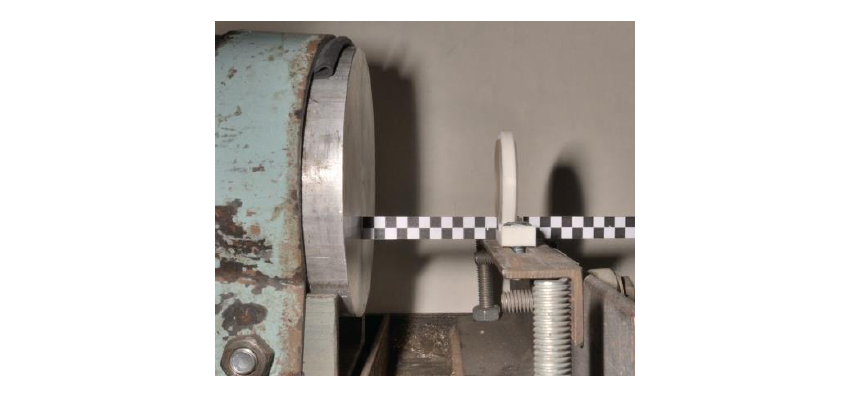
Fig 3. The locations of plexiglass and the barrier-“witness” Fig. 4a shows the interaction of a spherical drummer with plexiglass at a speed of V 0 = 1595 m/s.